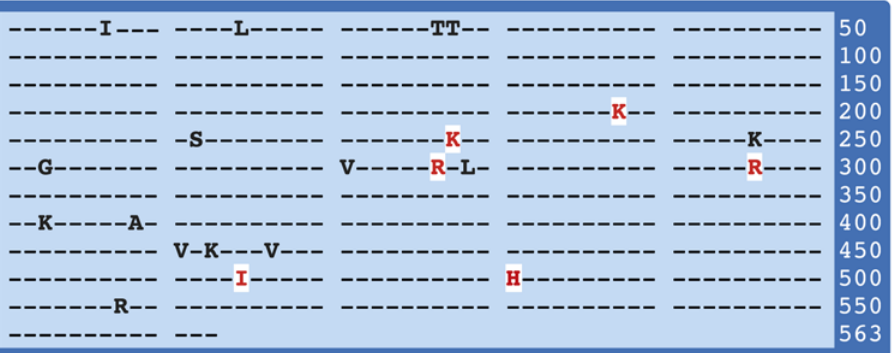
Fig 1. Polymorphic residues in the PkAMA1 protein. High frequency polymorphic sites in red, bold and highlighted in white; low frequency polymorphic sites in black.